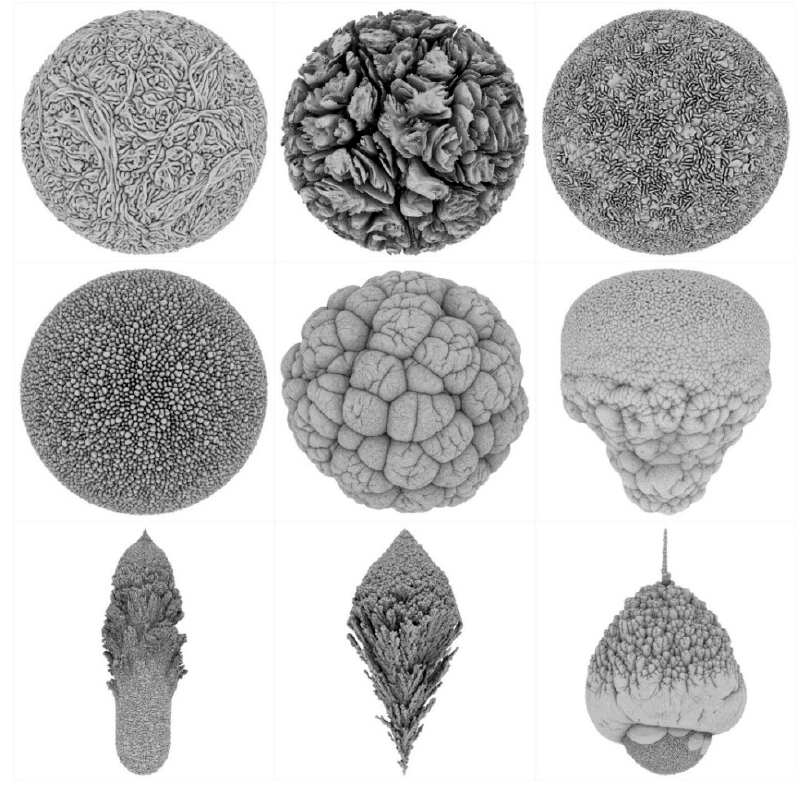
Figure 2. Examples of a range of morphologies from the author’s Cellular Forms (Lomas 2014).